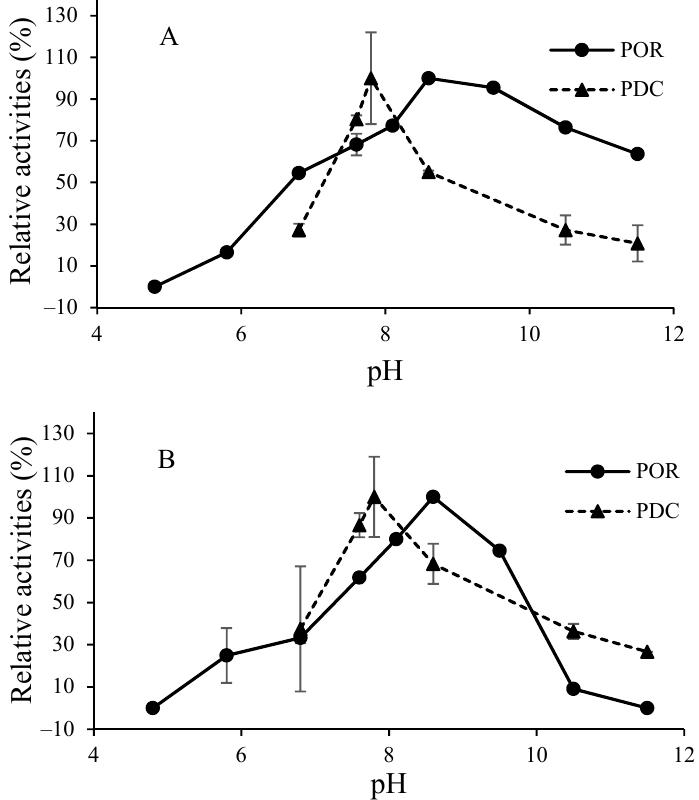
Figure 4. pH dependence of the POR and PDC activities of the bifunctional POR/PDCs from S. solfataricus ( A ) and S. acidocaldarius ( B ). POR activities were assayed using 5 mM pyruvate, 1 mM methyl viologen, 100 µM CoA, and approximately 50 µM sodium dithionite at 80 °C. The following buffers (100 mM) were used: sodium phosphate (pH 4.9, 5.9, and 6.9), glycine (pH 7.6, 8.1 and 8.6), and CAPS (pH 9.5, 10.5, and 11.5). PDC activities were measured using 10 mM pyruvate and 100 µM CoA at 80 °C. The following buffers were used: sodium phosphate (pH 6.9, and 7.9), glycine (pH 7.6, and 8.6), and CAPS (pH 10.5, and 11.5). The relative activities of 100% are equal to the highest specific activities (2.2 U/mg for SsPOR, 0.16 U/mg for SsPDC, 0.55 U/mg for SaPOR and 0.052 U/mg for SaPDC activity).